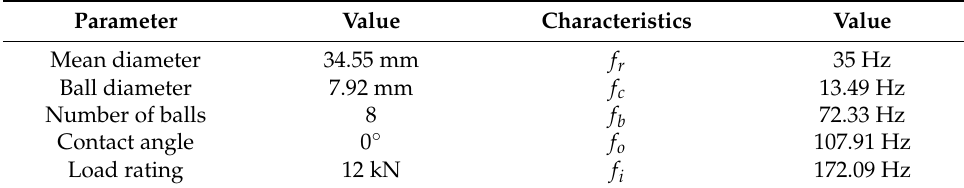
Table 2. Test bearing specifications ( f r : shaft speed, f c : cage frequency, f b : ball spin frequency (BSF),